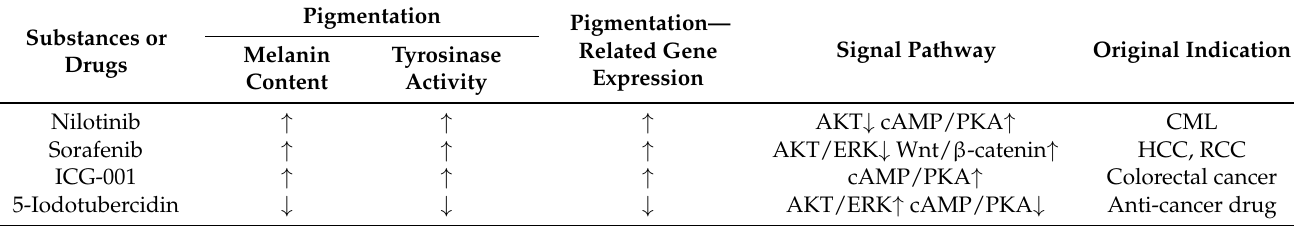
Table 3. Summary of research results on substances and drugs used to develop pigmentation-regulating agents by drug